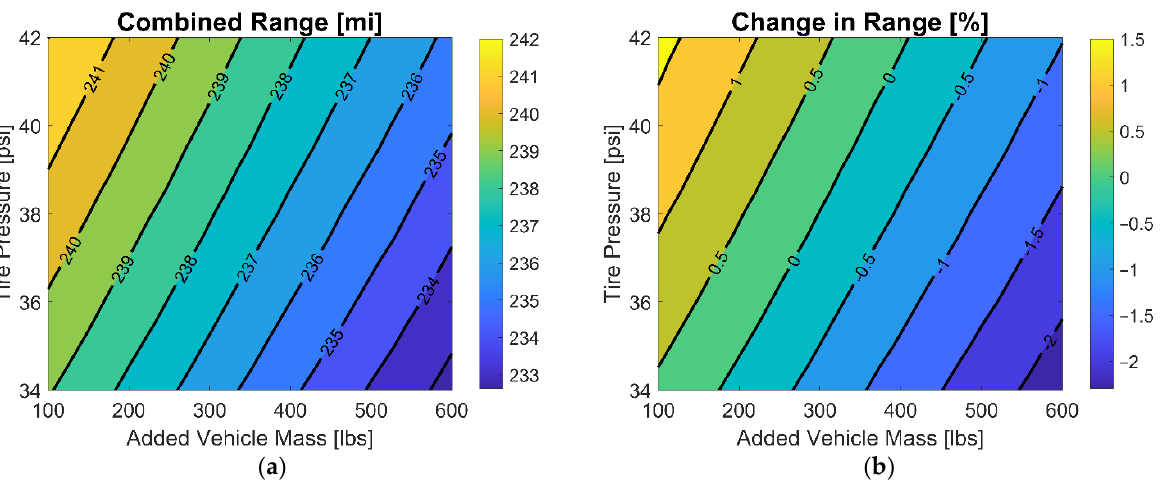
Figure 10. ( a ) Combined range in miles and ( b ) percentage change in range for a Chevy Bolt based on the added vehicle mass and tire pressure.